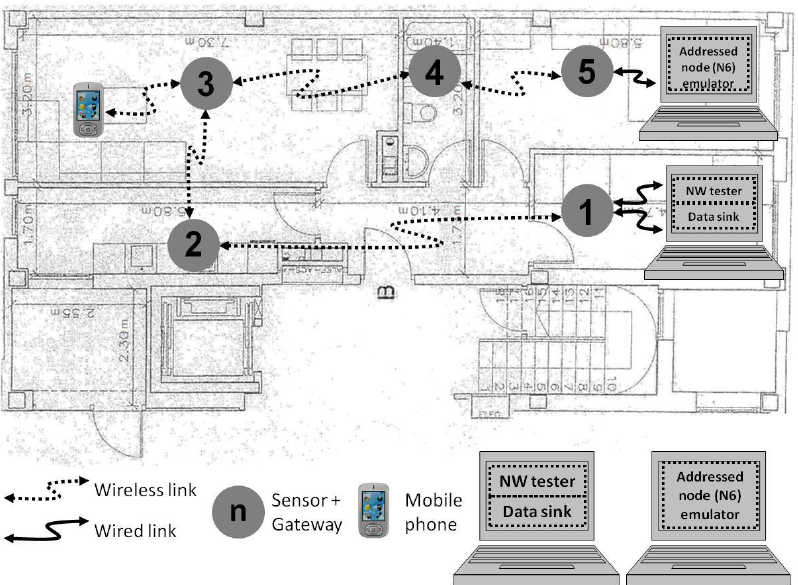
Figure 3. Example of multi-hop network deployment for an intelligent environment inside a home (distances expressed in